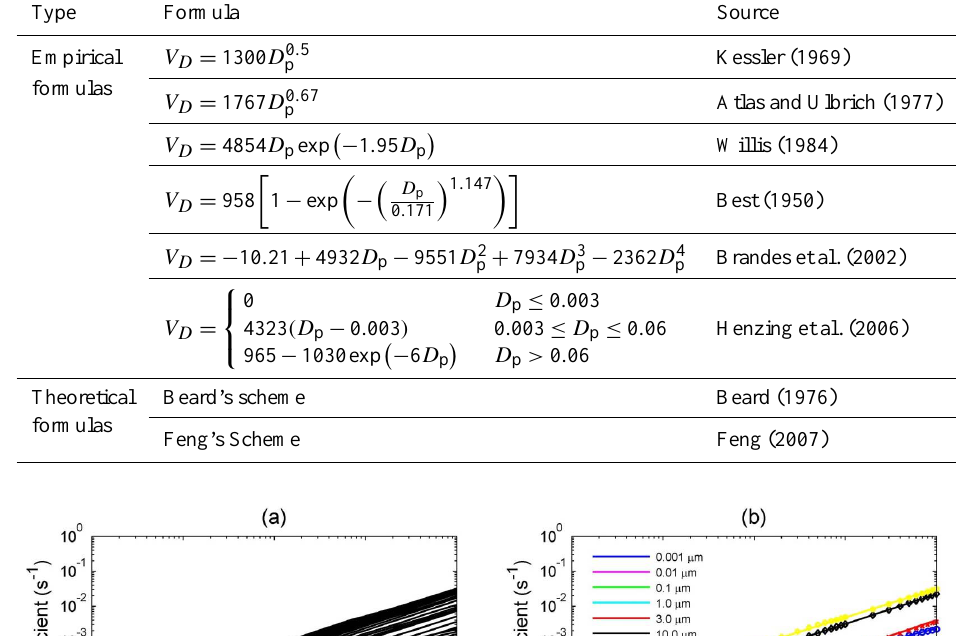
Table 3. List of empirical and theoretical raindrop terminal velocity ( V D ) formulas.